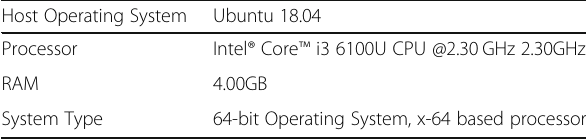
Table 3 System Properties of the Implementation Machine